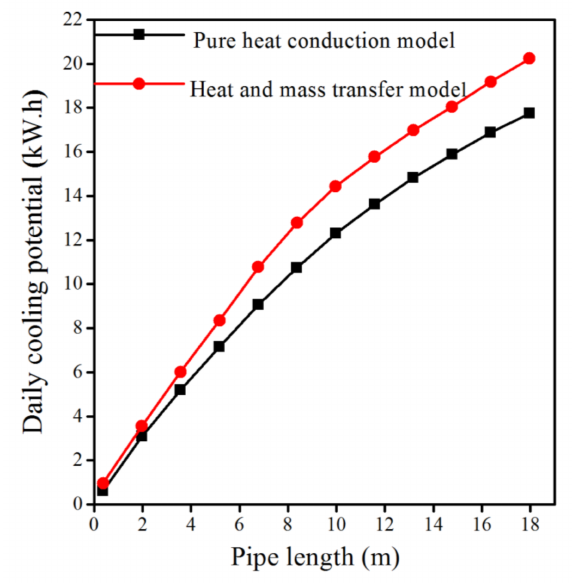
Figure 12. Variation of the daily cooling potential along the pipe length under different heat transfer